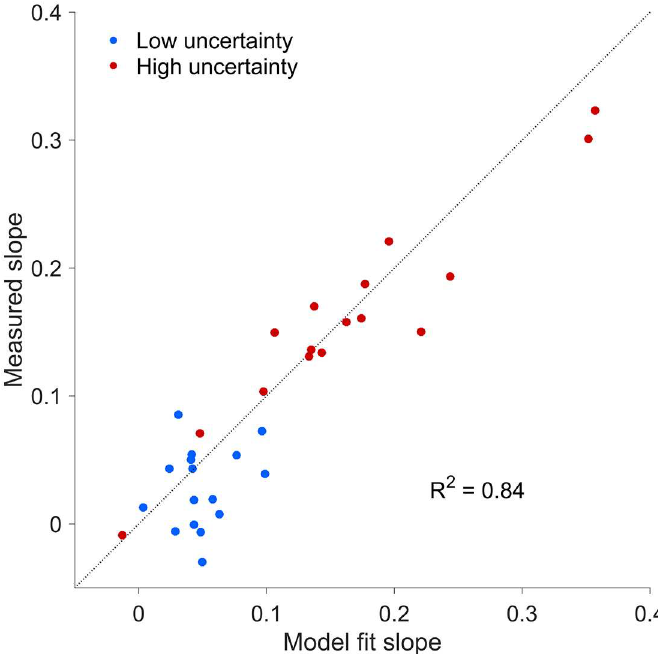
Fig 5. Slope of mean residual error with respectto perturbation, comparison between data and model. Each circle representsthe slope of the mean residualerror (Fig 2B) for a single subject for Low- uncertainty trials (blue dots) and High-uncertainty trials (red dots). The x axis indicatesthe slope predicted by the Bayesianobservermodel, whilethe y axis reports the slope measuredfrom the data (slope of linear regressions in Fig 2B). The model correctly predicts the substantialdifference betweenLow-uncertainty and High-uncertainty trials and is in good quantitative agreement with